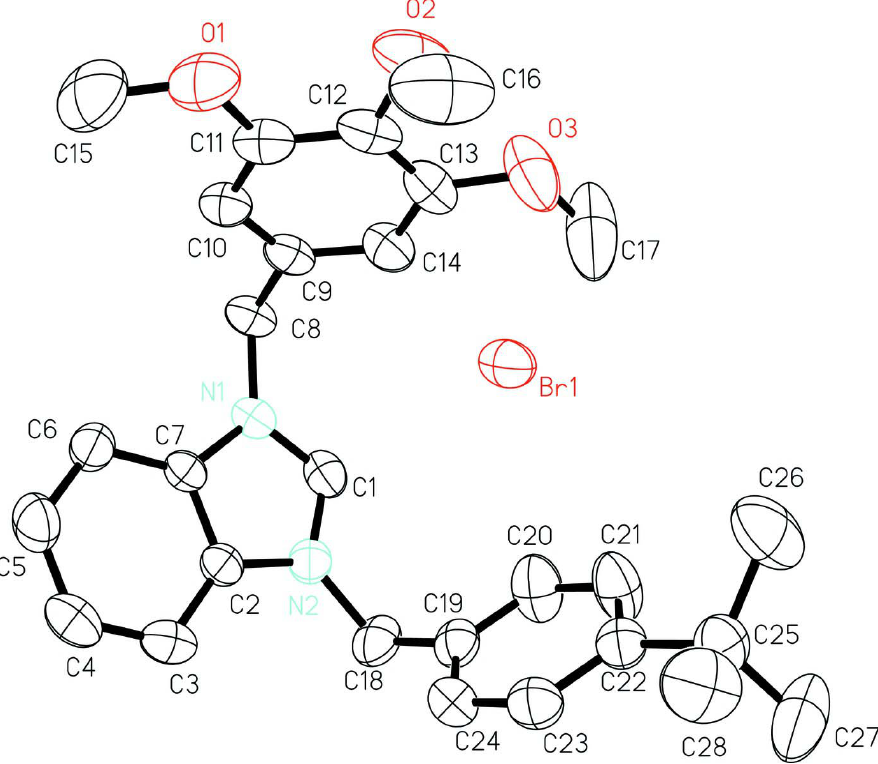
The molecular structure of the title compound, showing the atom-numbering scheme and displacement ellipsoids drawn at the 50% probability